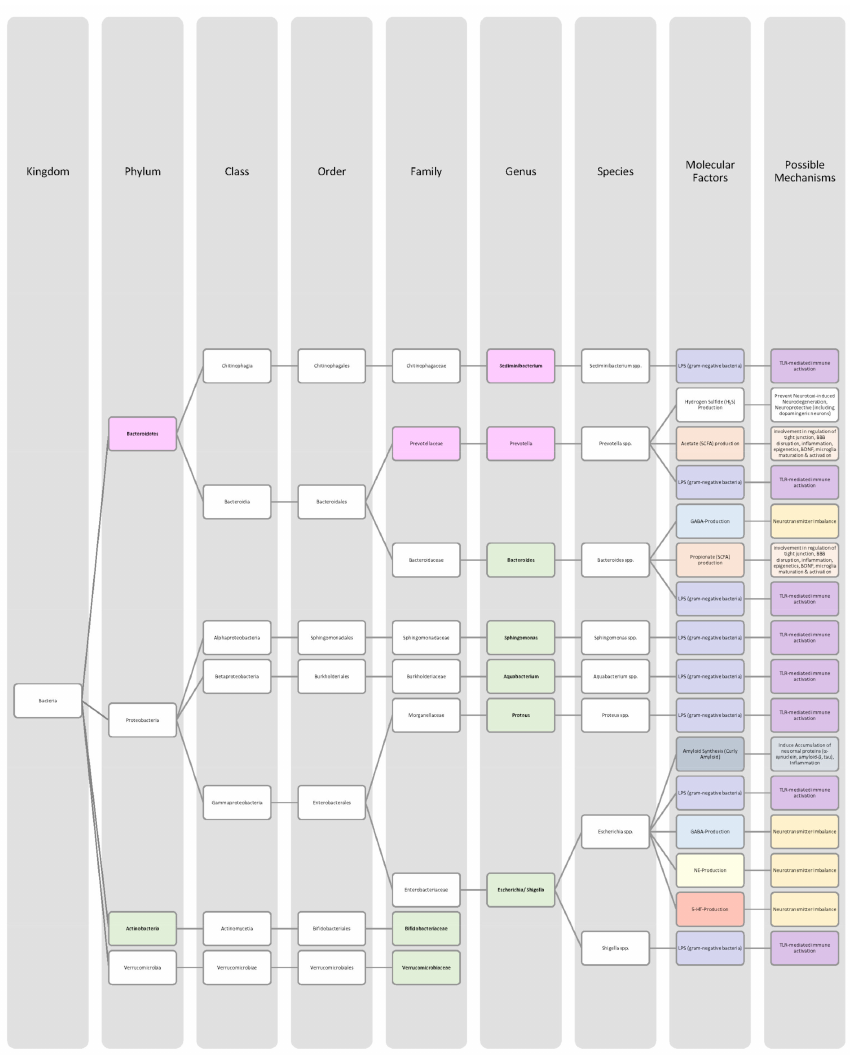
Figure 9. Part 2 of visual representation of the changes in microbiota composition in Parkinson’s disease (PD) patients from Table 6. For Figures 8 and 9: The pedigree design highlights the taxonomic classification of the dysbiotic bacteria. Light green cells stand for an increase and the light red cells for a decrease, respectively. Significant changes are shown in bold letters ( p < 0.05 or LDA values > 2). White cells indicate that no changes were reported or, in the case of Lactobacillus, both significant increases and decreases were found. The last two columns contain additional, non-exhaustive information on how the bacteria are thought to impact the pathogenesis. The second last column to the right depicts bacterial molecular factors, which may be components of the bacteria or bacterial metabolites. Finally, the last column lists possible mechanisms, by which these molecular factors may interfere with disease development. The colours summarise factors or mechanisms that are repetitive. Bacterial production or involvement in the metabolism of GABA (light blue,